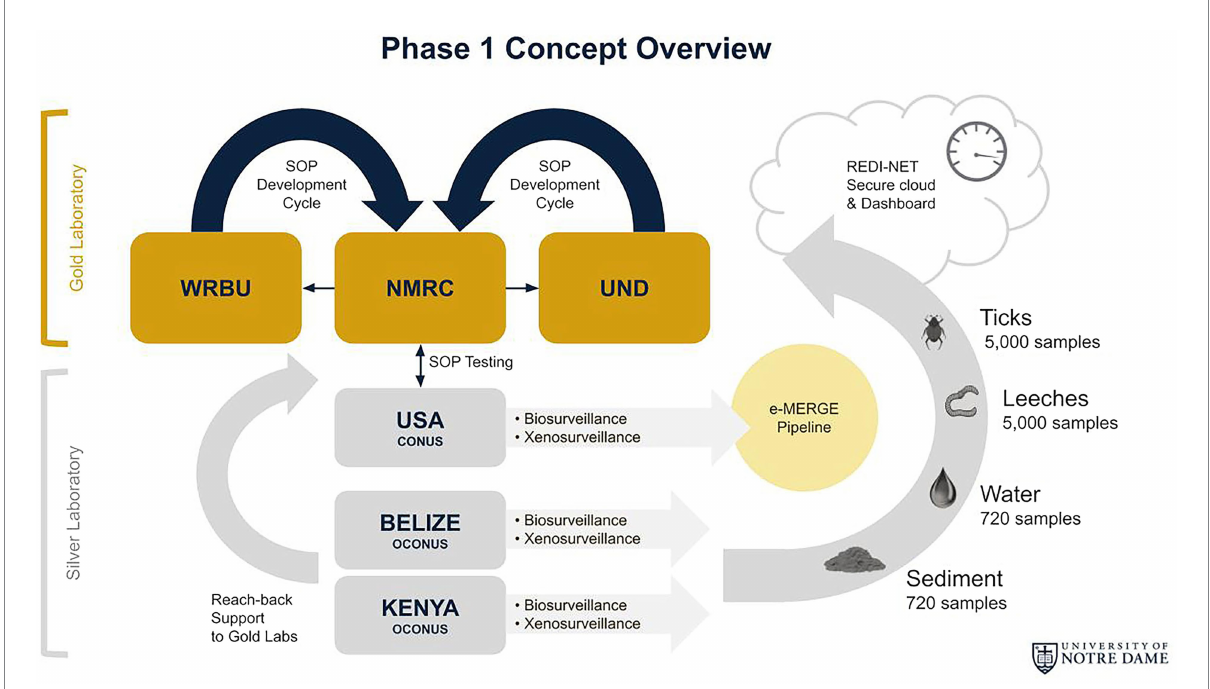
FIGURE 1 REDI-NET Phase I Concept Overview: (1) Establish robust SOPs for rigorous data capture and matched capabilities at Gold reach-back laboratories; (2) Active field surveillance across varied ecologies for broad pathogen catchment; (3) Enable remote, verified in-situ , near real-time data acquisition for actionable reporting; and (4) Institute a data management pipeline for actionable reporting and threat